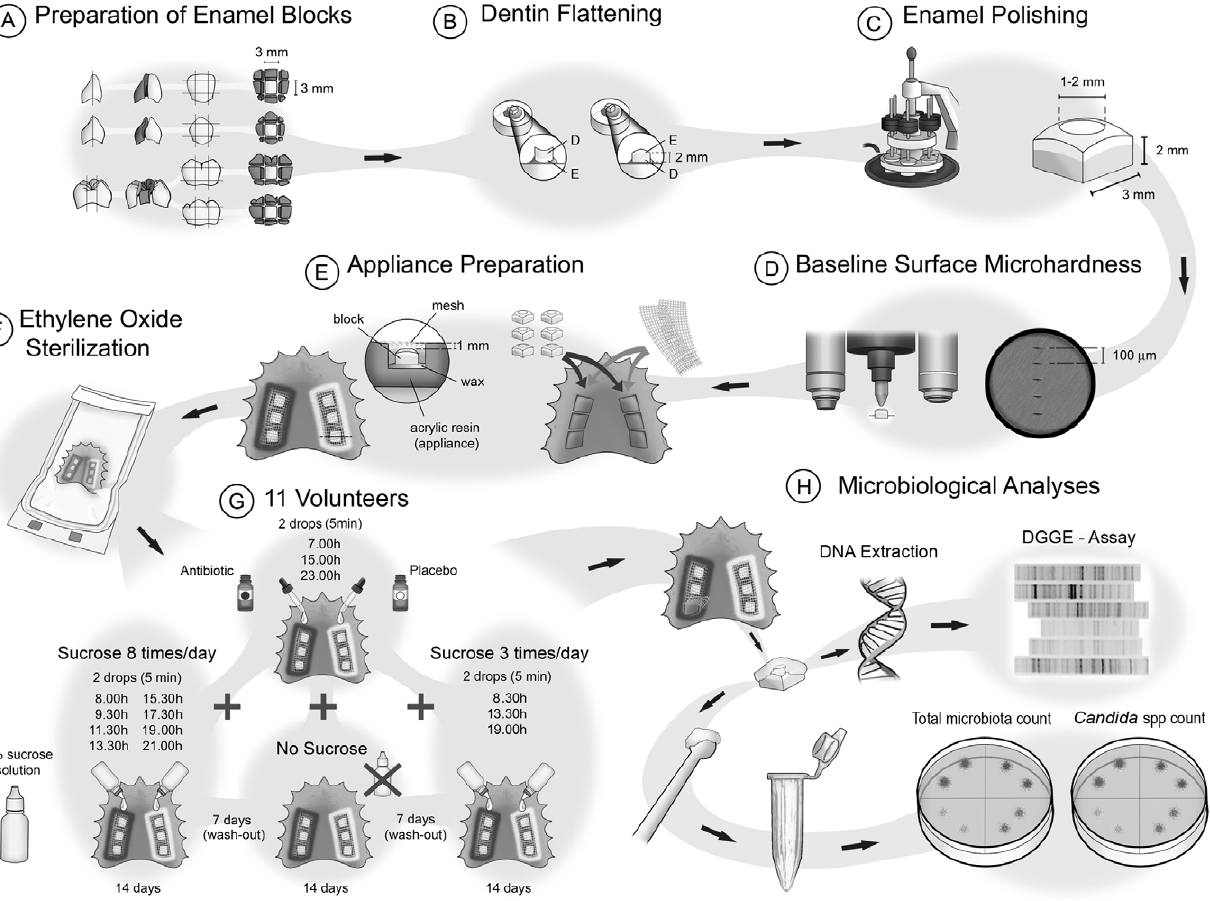
Figure 1. Schematic illustration of the experimental design.